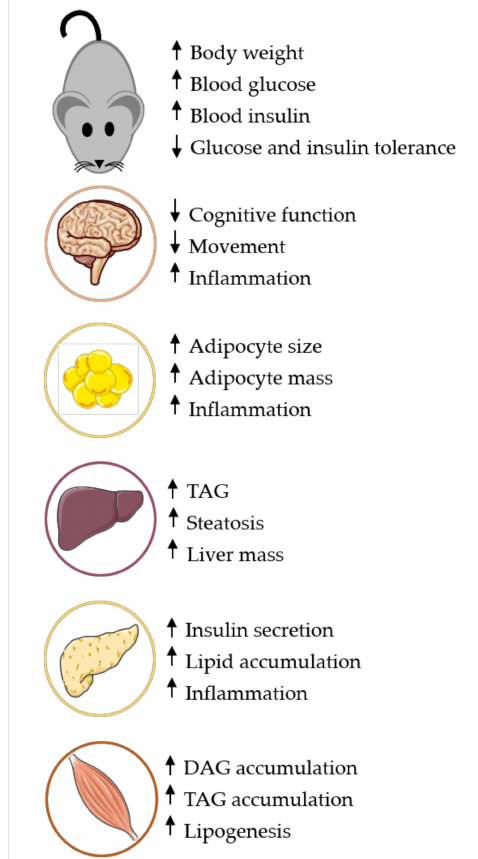
Figure 1. Rodent tissue responses to Western-like diet. A 45% HFD provides a progressive development of tissue and whole-body changes consistent with the T2D-like phenotype. Using higher fat percentages